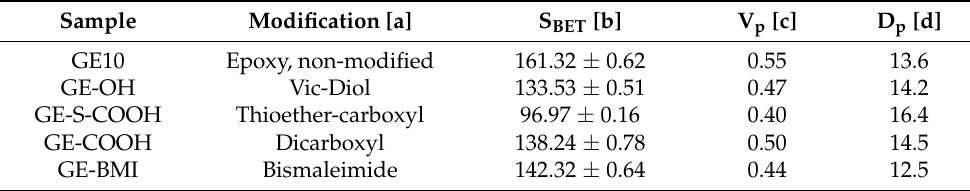
Table 6. Effect of surface modification on porous